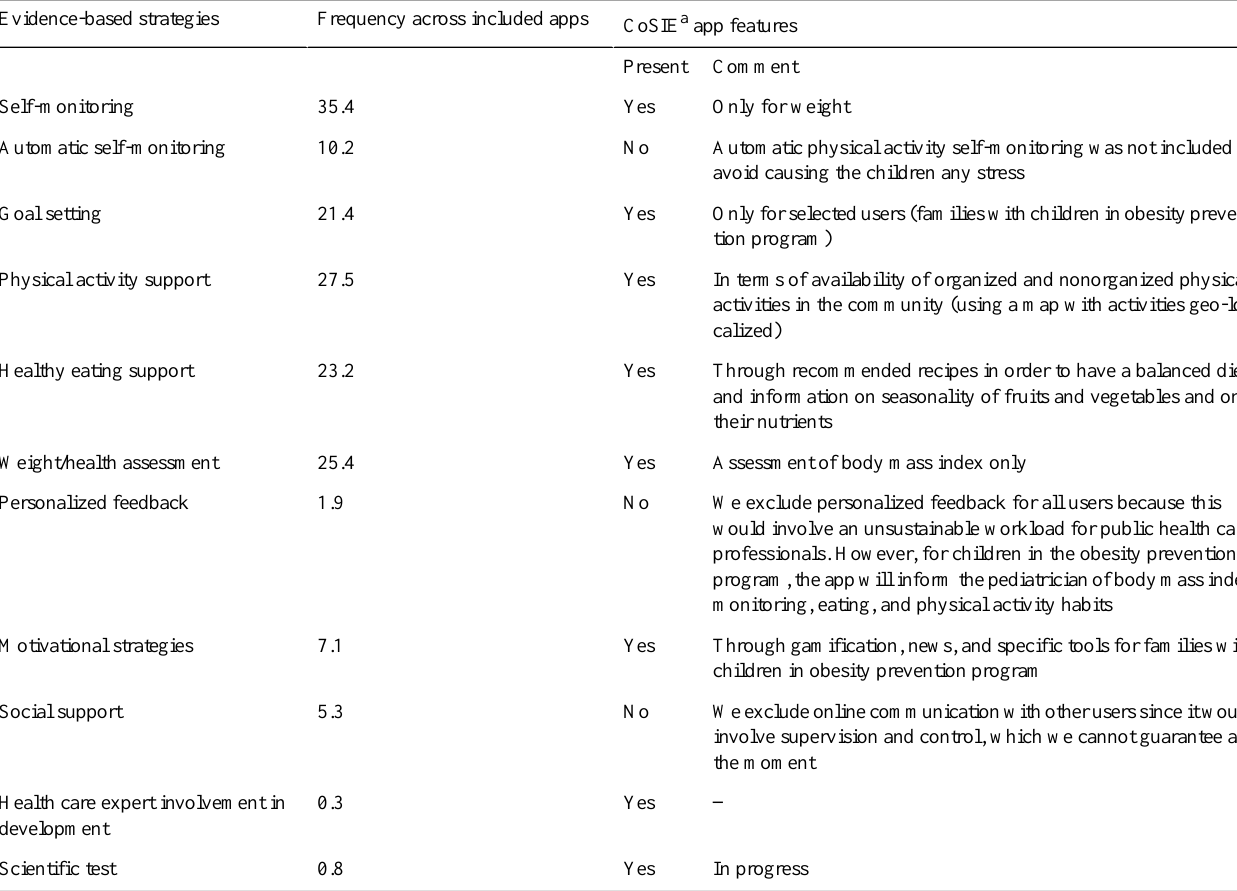
Table 1. Evidence-based strategies, health care expert involvement, and scientific testing in apps for weight management and in the CoSIE app. Adapted from Rivera et al [38]